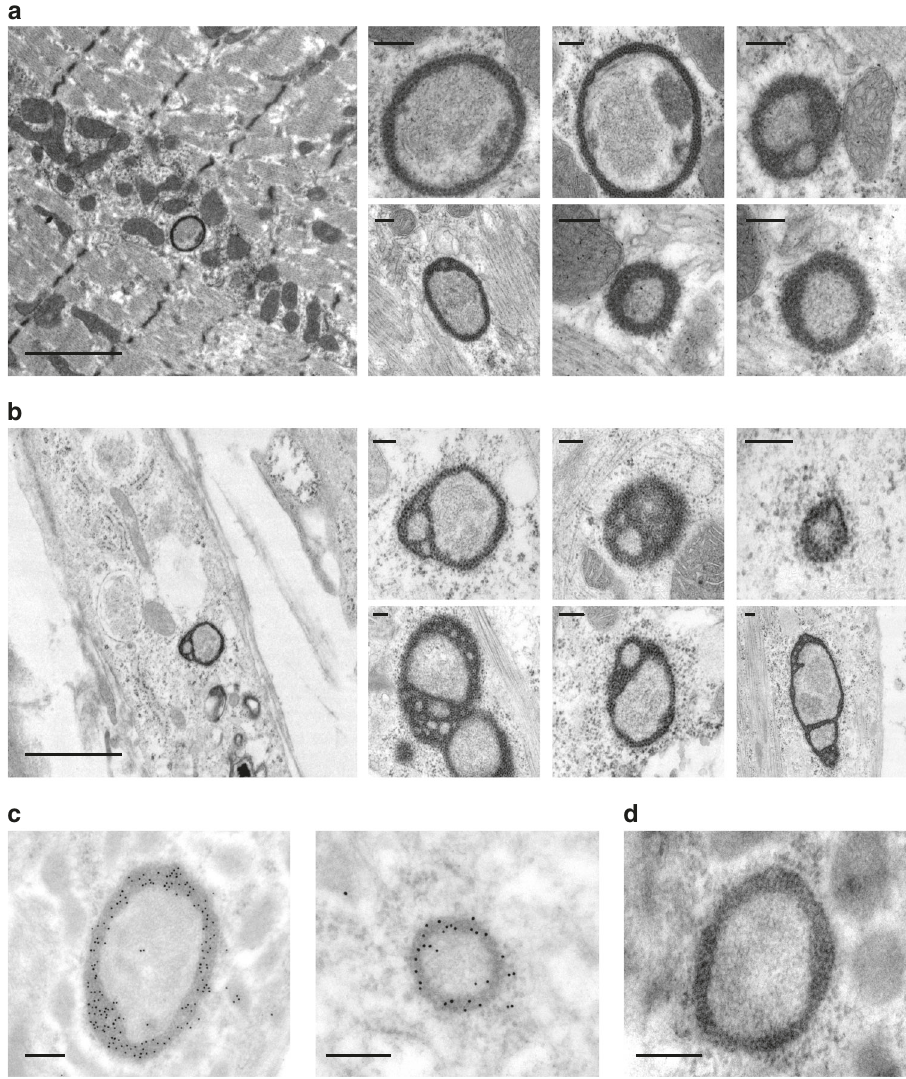
Fig. 7 Ultrastructural evaluation of delACAG granules. a Representative TEM images of granules of different size exclusively observed in gastrocnemius fi bers from delACAG mice. Granules are often located in close proximity to mitochondria. n = 3(wt), 4(delACAG), 2(dupA) mice. Scale bars 2 µ m (left panel), 200 nm (rest of panels). b Representative TEM images of ring-shaped granules from V-4 differentiated myotubes. These structures were not present in control differentiated myotubes. Multiple myotubes were analyzed. Scale bars 2 µ m (left panel), 200 nm (rest of panels). c Anti-FXR1P immunogold labeling of ultrathin sections from gastrocnemius of delACAG mice showing localization of the mutant protein in the outer electrodense layer of delACAG granules. n = 3. Scale bar 200 nm. d No-primary antibody control demonstrating no immunogold labeling in granules from delACAG